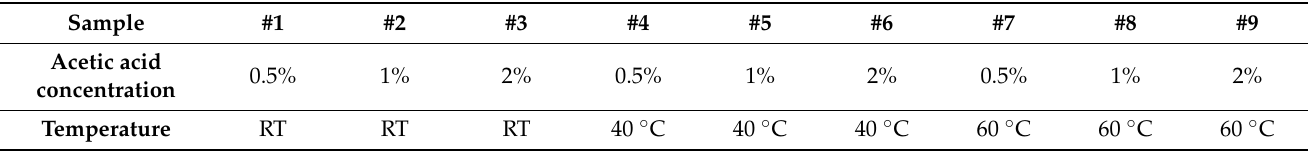
Table 1. Preparation of AuNPs in chitosan using different